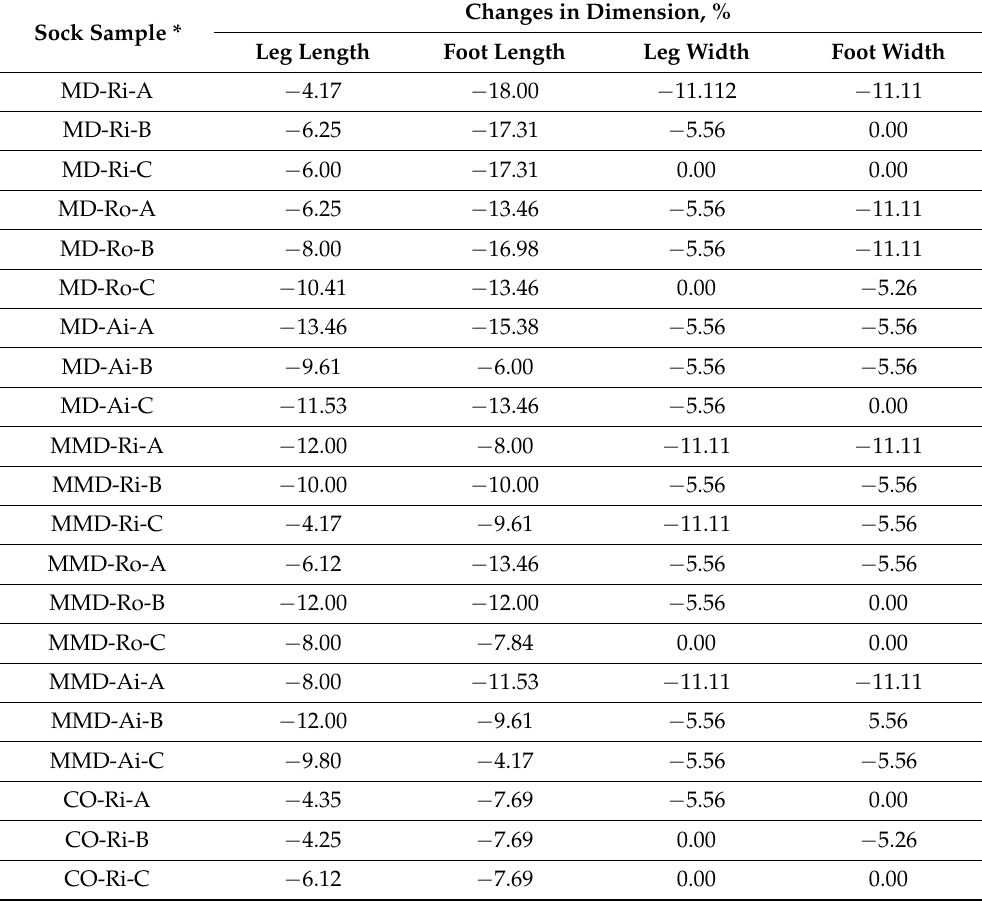
Table 8. Dimensional stability of the socks after five pretreatment